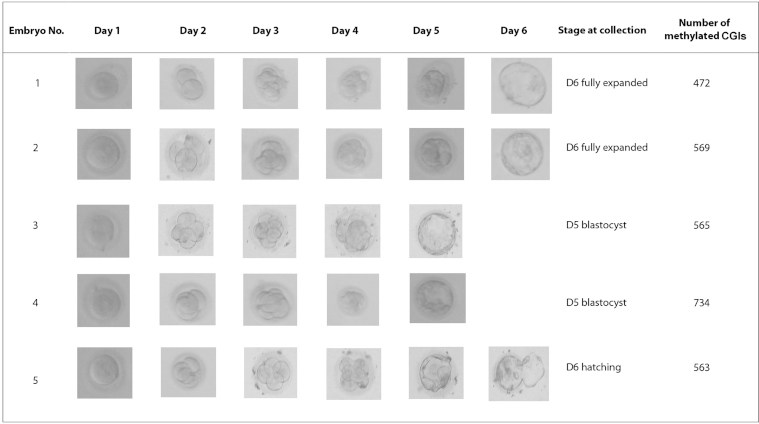
Images of the human preimplantation embryos used in the MCAM study, indicating the number of methylated CGIs in each embryo. CGI = CpG island; MCAM = methylated CpG island amplification coupled with microarray.